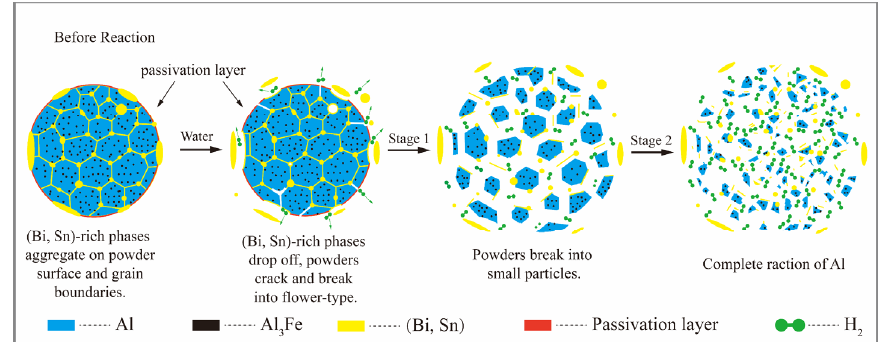
Figure 12. Schematic illustration of the reaction mechanisms of the Al-10Bi-7Sn-xFe (x = 0.5, 1.5, 3) (wt.%) composite powders reacting with distilled water at 30 °C.